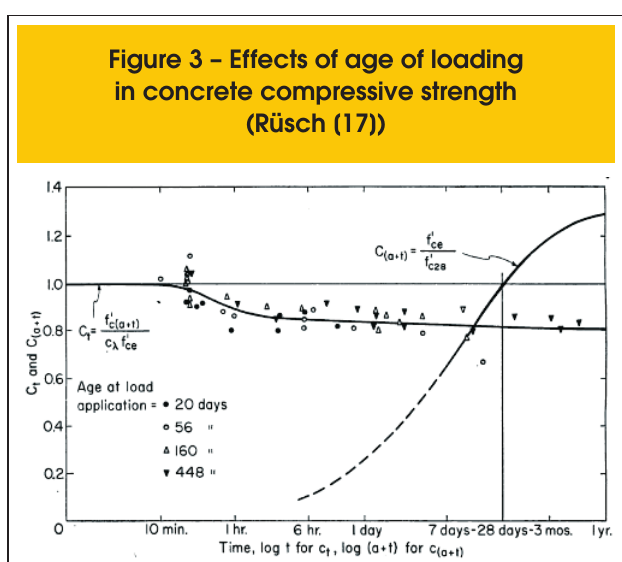
Figure 2 – Influence of duration and intensity of axial loading in concrete compressive strength (Rüsch [17])